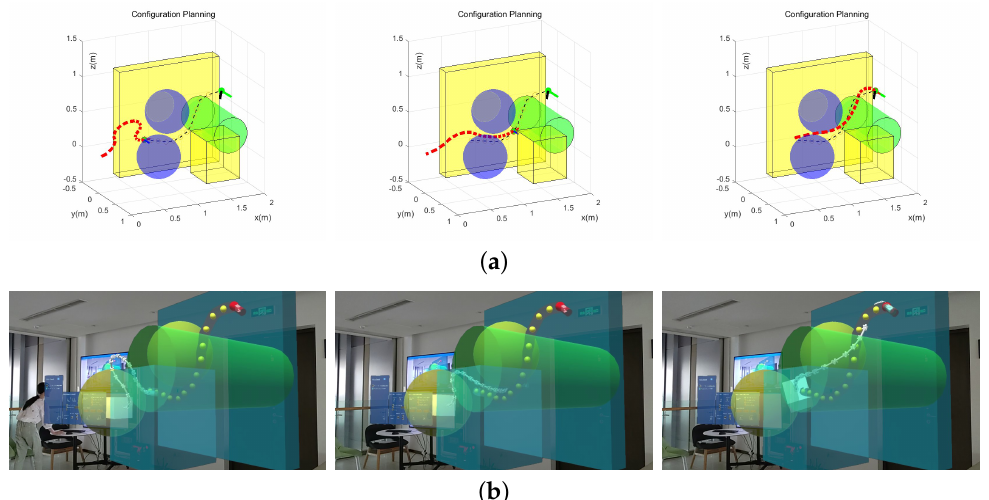
Figure 10. The results in chronological order of the ( a ) configuration planning simulation and ( b ) configuration planning simulation with the Base Lock option